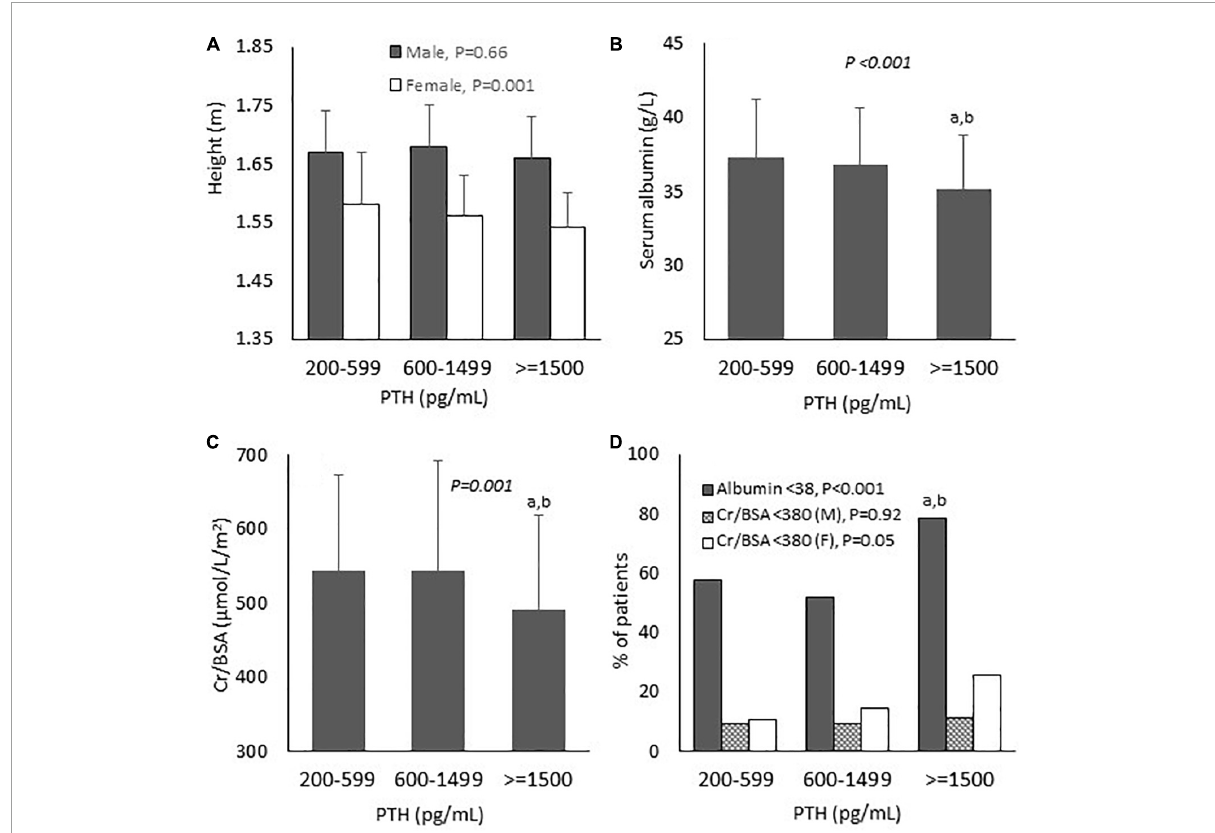
FIGURE2 Baseline biochemical and nutritional parameters according to parathyroid hormone levels. (A) Height; (B) Serum albumin; (C) Serum creatinine/body surface area; and (D) Proportion of patients with nutritional impairment. PTH, parathyroid hormone; Cr, creatinine; BSA, body surface area; M, male; F, female. P -values in the graphs represent the significant difference between all groups. a P < 0.01 vs. PTH 200–599; b P < 0.01 vs. PTH